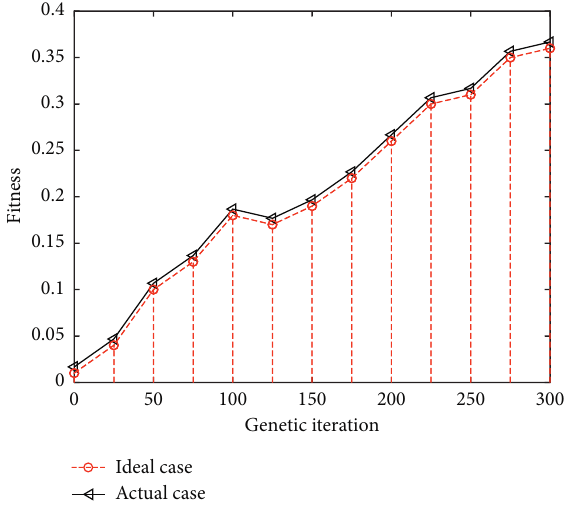
Figure 5: Average fitness curve.